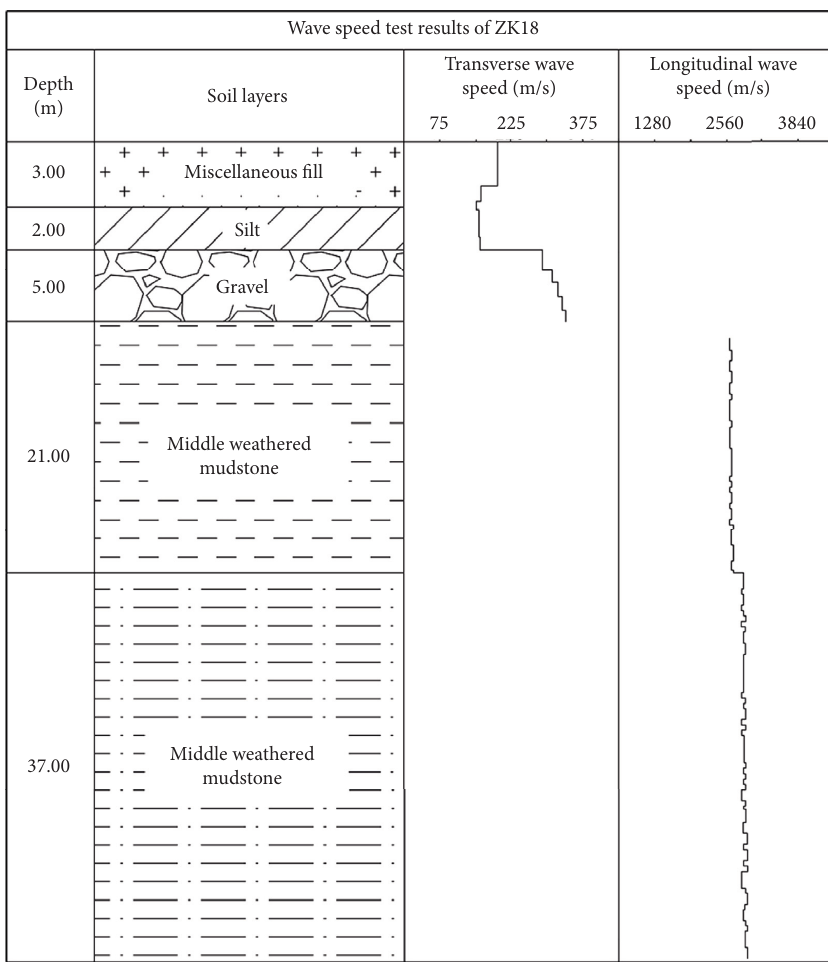
Figure 25: Wave speed test results of